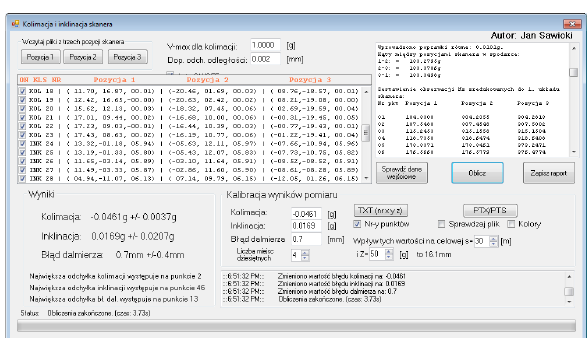
Figure 7. Computer application for proposed algorithm implementation